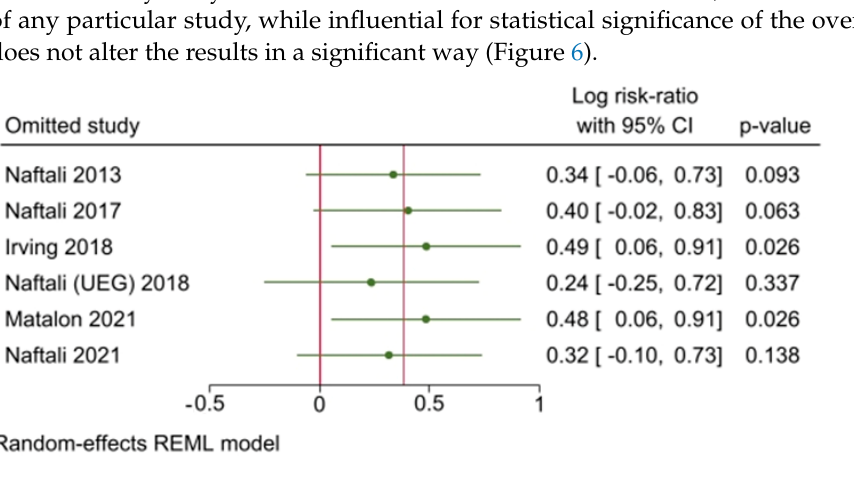
Figure 6. Leave-one-out analysis plot. Values > 0 favor treatment, values < 0 favor control [43–48].